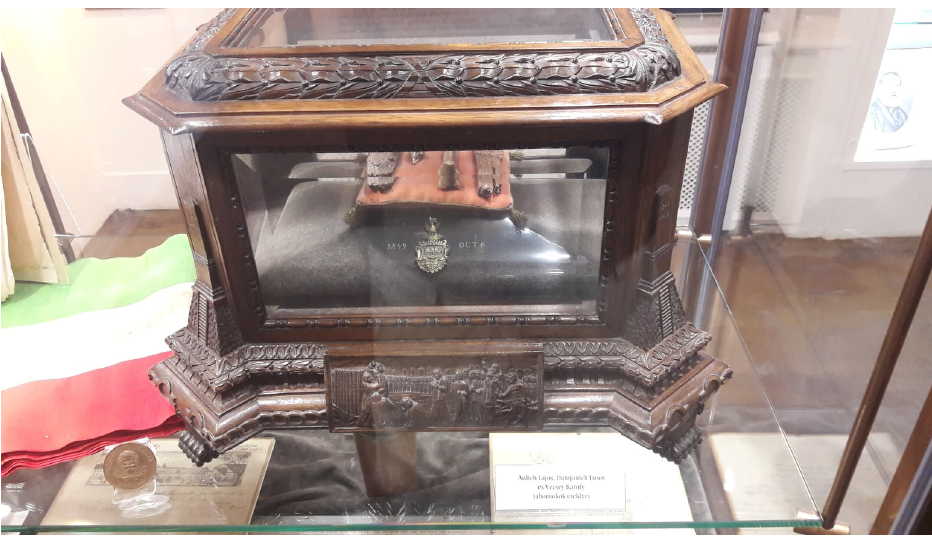
Figure 1. From the Déri Museum, Debrecen. The text explicitly mentions the “relics” of the martyrs: generals Lajos Aulich, János Damjanich, and Károly Vécsey.